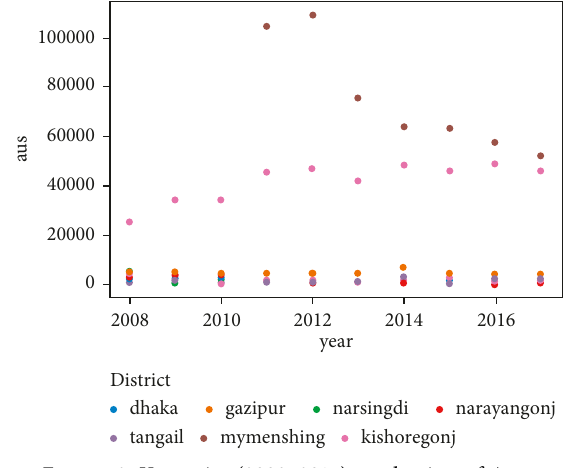
Figure 2: Year-wise (2008–2017) production of Aus.